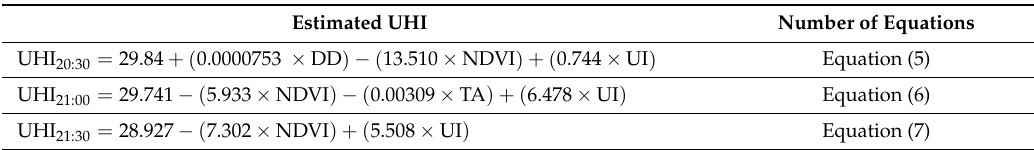
Table 2. Equations obtained for maximum urban heat islands (UHI) intensity.